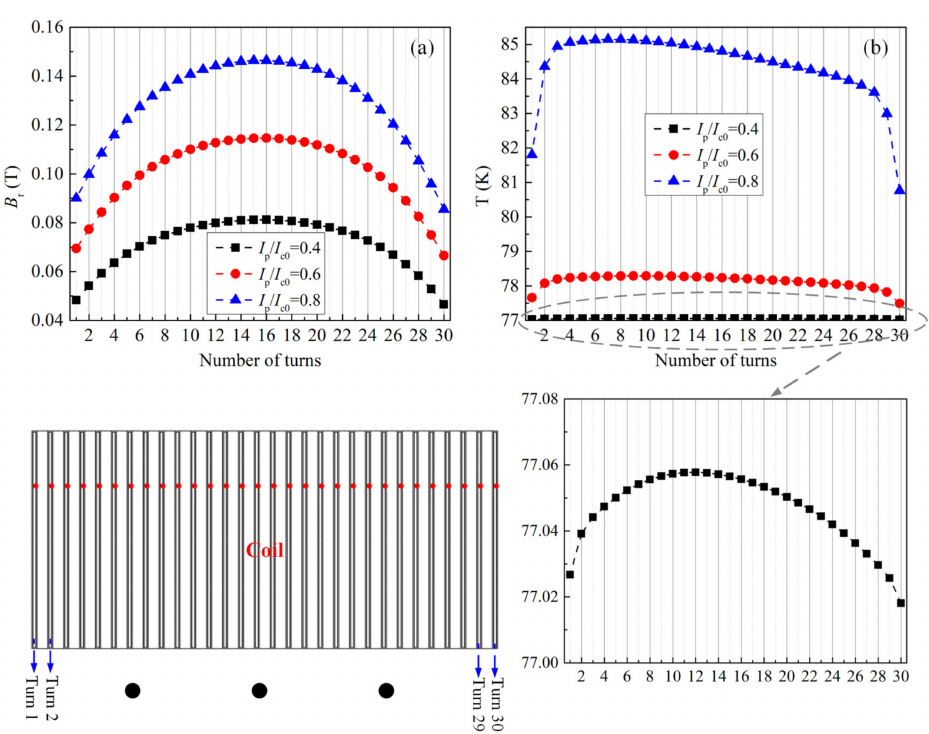
Figure 9. Radial flux density and temperature change with coil turns: ( a ) t = 0.01 s: the change in radial magnetic flux density with coil turns under different fault currents; ( b ) t = 0.3 s: temperature changes with coil turns under different fault currents. The sampling point is shown by the red dot at the lower left corner of the